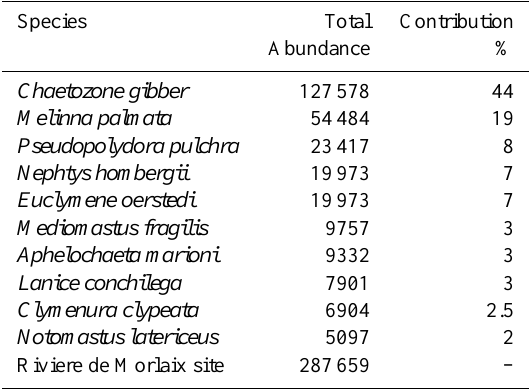
Table 2. List of most abundant species and contribution to total abundance for the RM site.